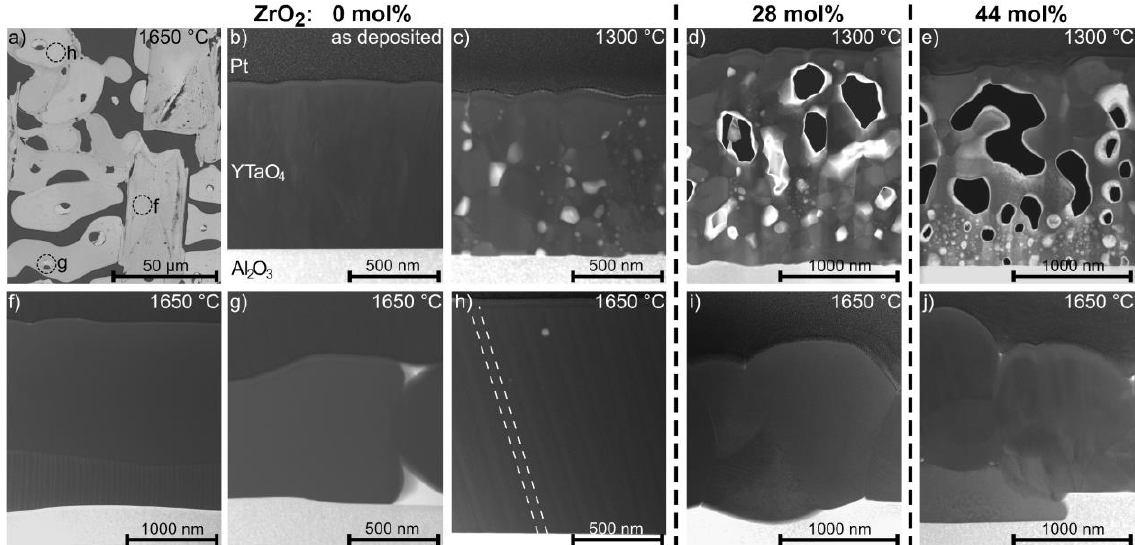
Figure 5. ( a ) Top-view SEM image of ZrO 2 free sample after annealing at 1650 °C; Dark field STEM images of cross-sections prepared by focused ion beam (FIB) milling of as-deposited ( b ) as well as annealed for 1 h at 1300 °C ( c – e ) and 1650 °C ( f – j ) for 0, 28, and 44 mol% ZrO 2 . Locations of cross-sections for ( f – h ) are indicated in a. Dashed lines in h highlight a twin.